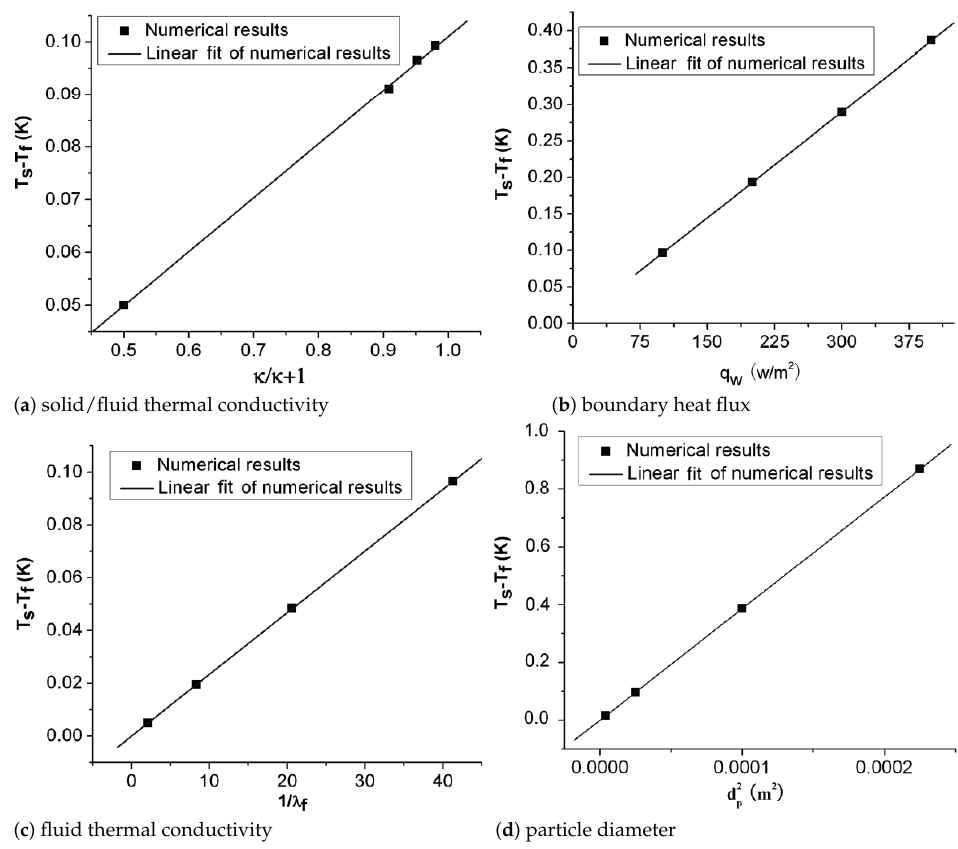
Figure 3. Profiles of average temperature difference between the solid and fluid phases for different ( a ) wall heat flux, ( b ) solid/fluid thermal conductivity ratio, ( c ) fluid thermal conductivity, and ( d ) particle diameter, reported by Zhang and Liu [34].